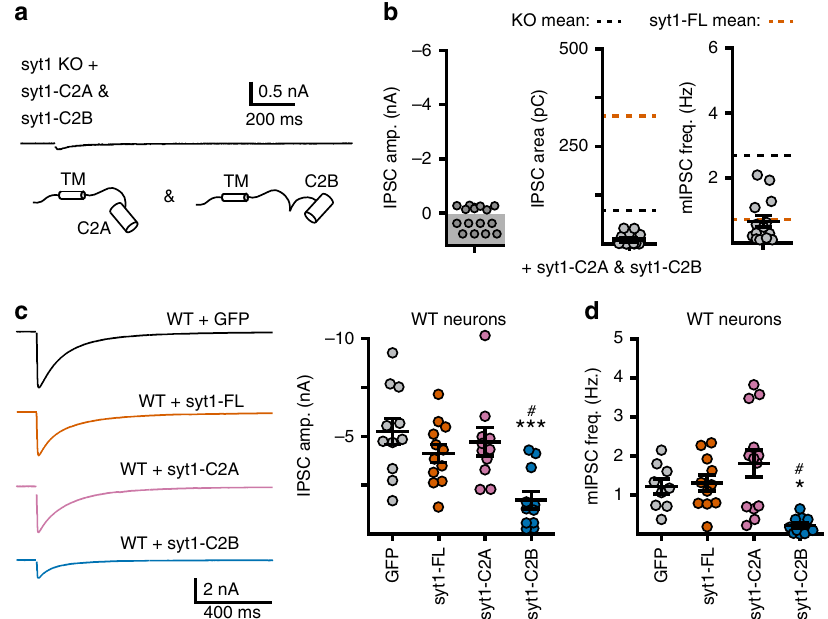
Fig. 4 C2 domains must be con fi gured in tandem for ef fi cient evoked fusion. a Average trace illustrating evoked IPSCs from syt1 KO neurons co-expressing syt1-C2A and syt1-C2B. b Quanti fi cation of IPSC amplitude, IPSC charge, and mIPSC frequency illustrating that co-expression of these constructs does not mimic the overall function of the full-length protein. Note, data from panels a and b were collected in parallel with the data presented in Fig. 2; dashed lines on the IPSC area and the mIPSC frequency graph represent the mean values of these measurements for KO (black) and syt1-FL (orange) from the data presented in Fig. 2. c Left: average traces of evoked IPSCs recorded from WT neurons overexpressing a control virus (GFP, black, n = 11), syt1-FL (orange, n = 12), syt1-C2A (pink, n = 11), or syt1-C2B (blue, n = 11). Right: quanti fi cation of IPSC amplitudes. d Quanti fi cation of the frequency of mIPSCs from WT neurons overexpressing GFP ( n = 9), syt1-FL ( n = 11), syt1-C2A ( n = 13), or syt1-C2B ( n = 11). Error bars represent